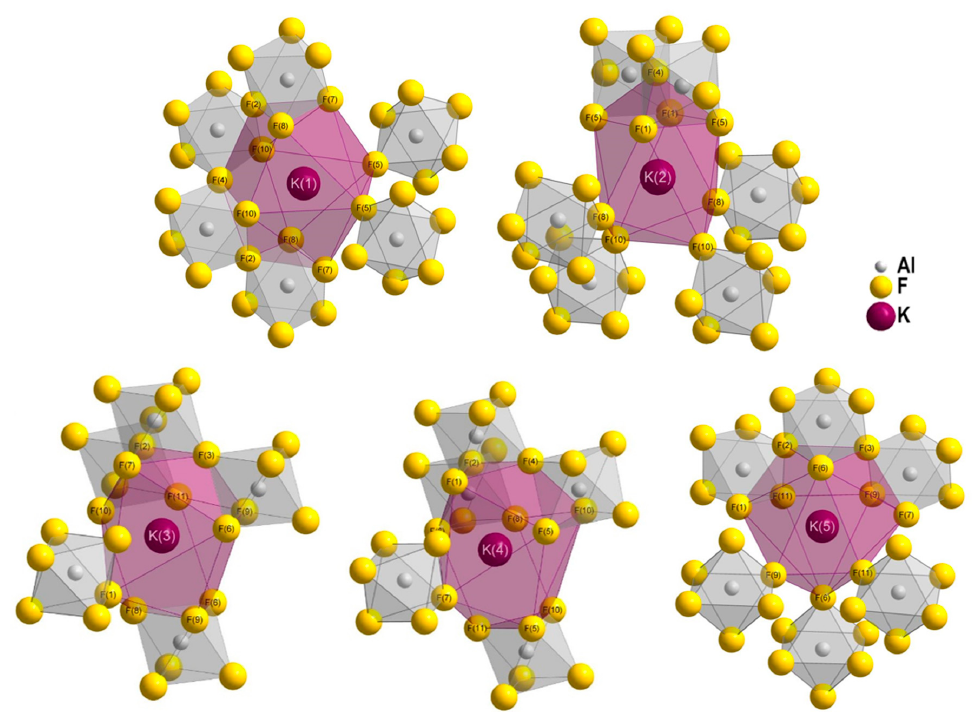
Figure 6. Potassium site coordination by AlF 6 -octahedra in K 2 AlF 5 -3. Each site connects three fluoridoaluminate chains.